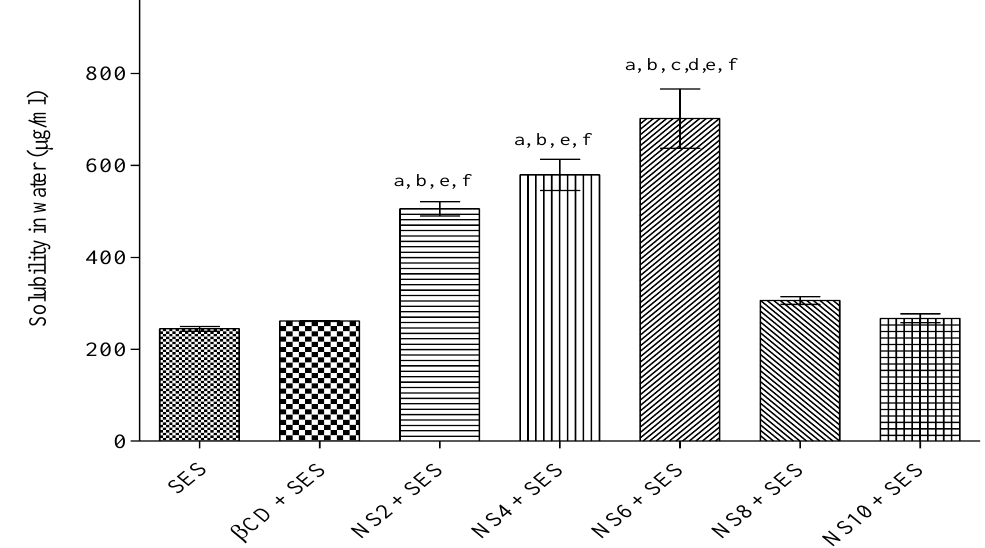
Figure 1. Solubilization of bare SES and SES along with β -CD, and various nanosponges (NS2, NS4, NS6, NS8, and NS10). Data represented as mean ± SD (n = 6). Statistical data were evaluated by using one-way ANOVA and subsequently using Tukey’s test for multiple data evaluations. (a) p < 0.001 vs. SES; (b) p < 0.001 vs. β -CD; (c) p < 0.001 vs. NS2; (d) p < 0.001 vs. NS4; (e) p < 0.001 vs. NS8; (f) p < 0.001 vs. NS10. SES: Sesamol; SES-NS: Sesamol- loaded nanosponge; β - CD: β -Cyclodextrin.